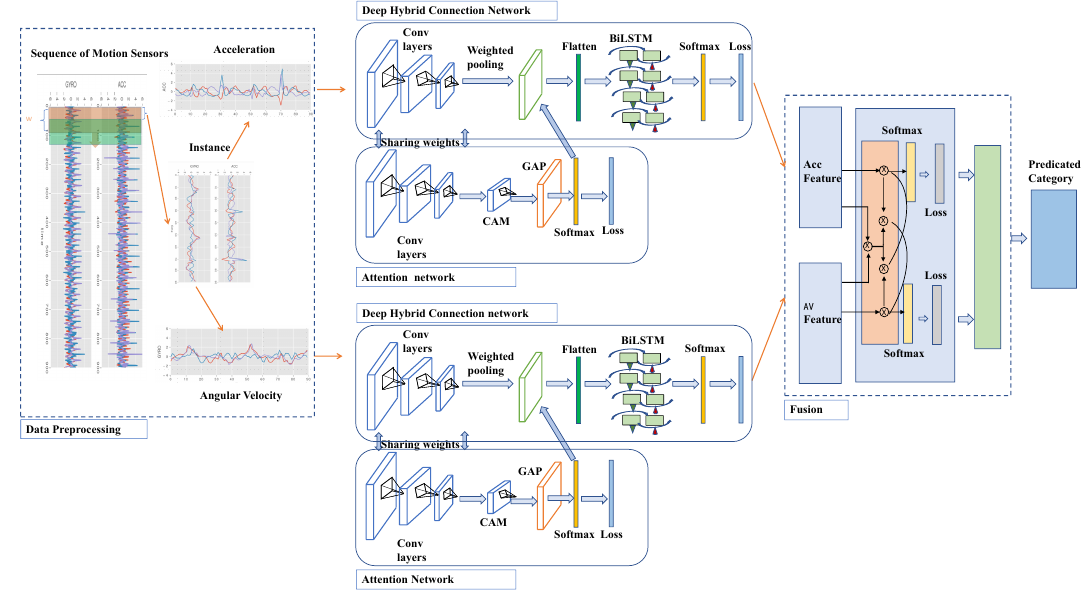
Figure 5. Overall architecture of the Sensing-HH